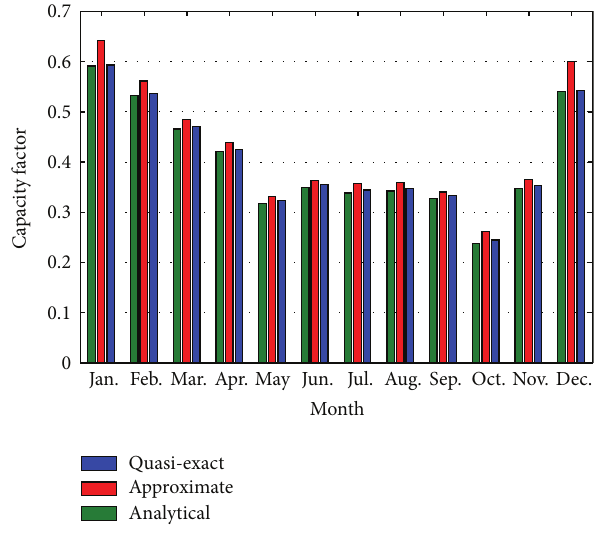
Figure 5: 2008 monthly capacity